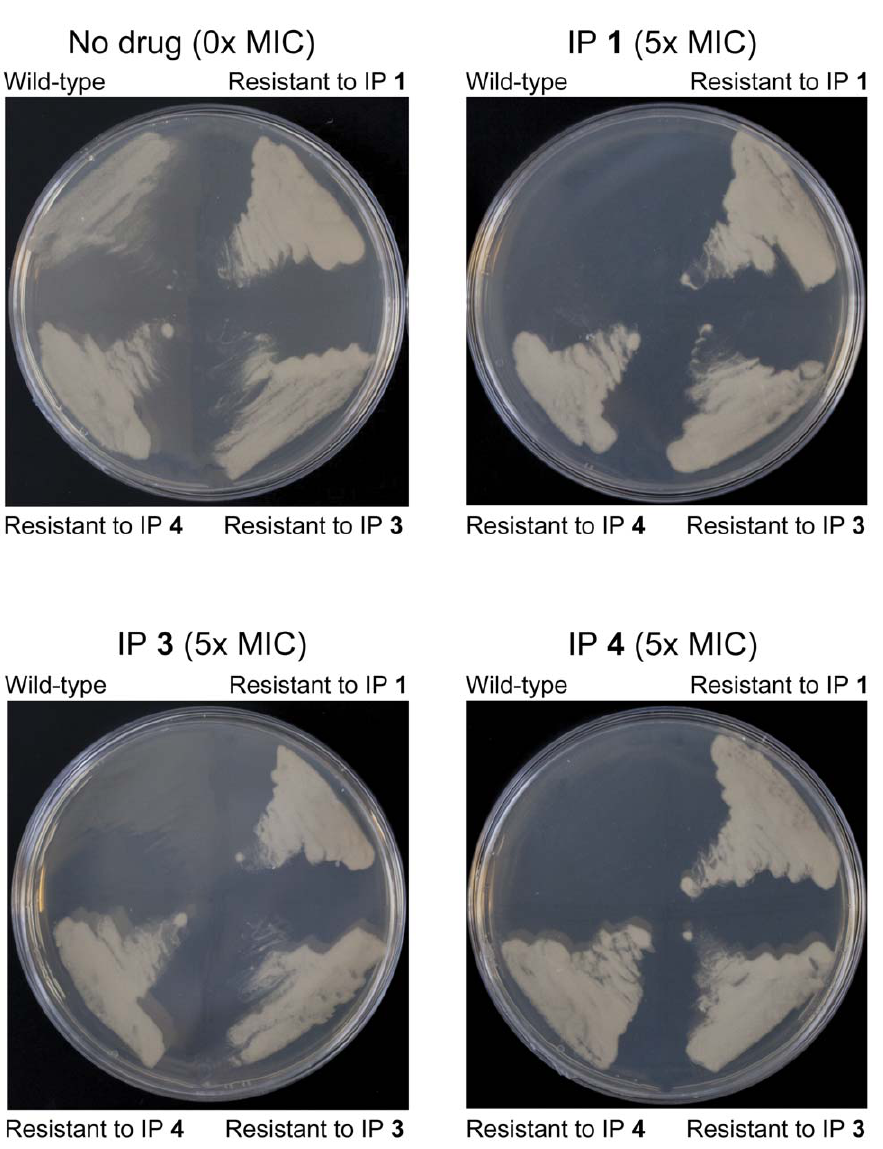
Figure 4. Cross-resistance of M.bovis BCG mutants resistant to IP compounds. M. bovis BCG resistant mutants raised against IP 1 , 3 and 4 were plated at 5 6 MIC of each of the respective compounds. A wild-type control demonstrates the resistant nature of the mutants.